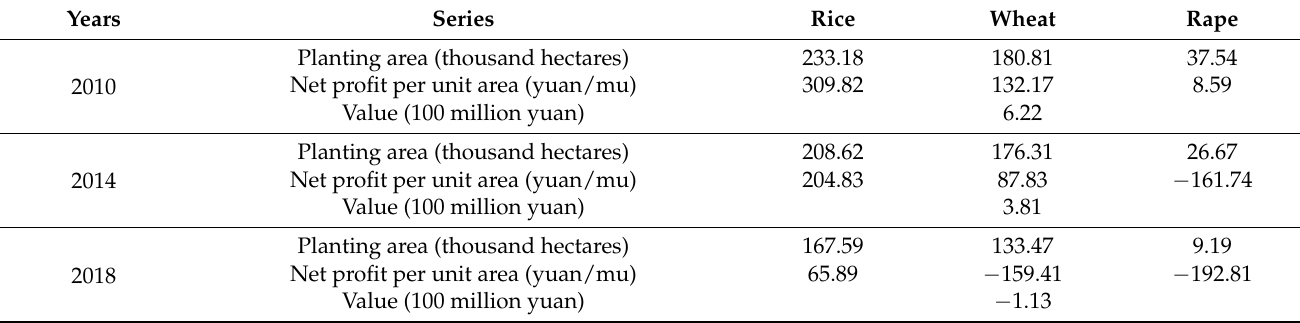
Table 11. The value of maintaining biodiversity calculated by planting area and average net profit per unit area of the three crops (rice, wheat, and